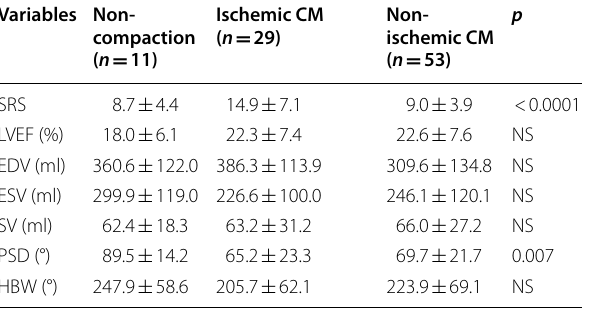
Age, QRS duration, LVEF, and MLHFQ results are expressed as mean CAD coronary artery disease, LVEF left ventricular ejection fraction, MLHFQ Minnesota Living with Heart Failure Questionnaire